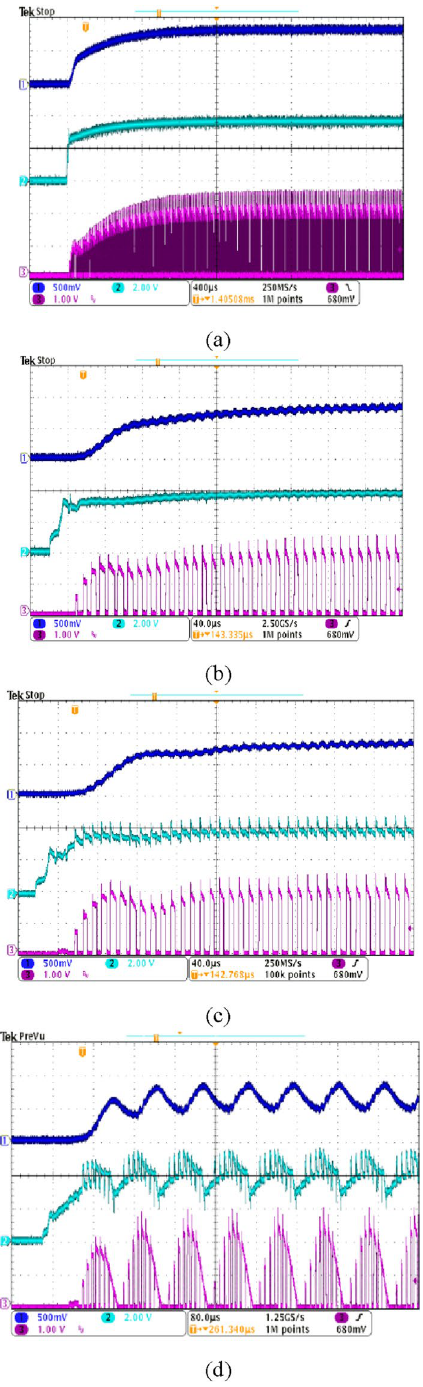
, ( b ) R ′ 1 = 12 k (cid:31) (cid:30) , and ( d ) k . Vertical scale: top traces- 0.1 R ′ 1 = 1.8 k R ′ 1 = 1 k ni ≈ (cid:31) (cid:30) (cid:31) (cid:30)